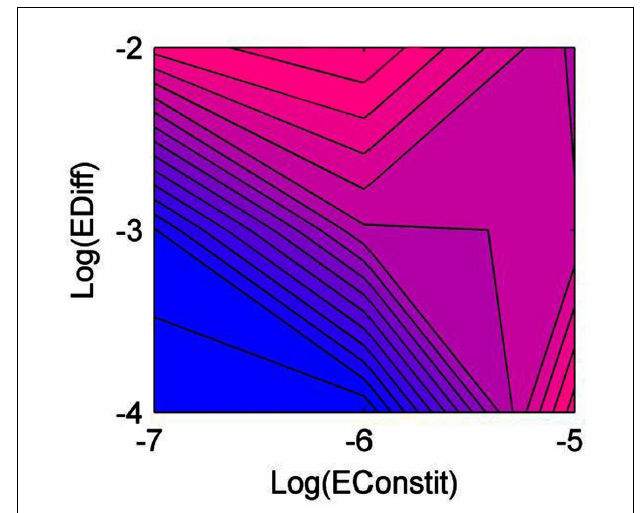
FIGURE 1 | Diversity of the community as a function of diffusion rate (EDiff) and constitutive enzyme production rate (EConstit), averaged over all replicate runs. Blue represents low diversity, and pink high